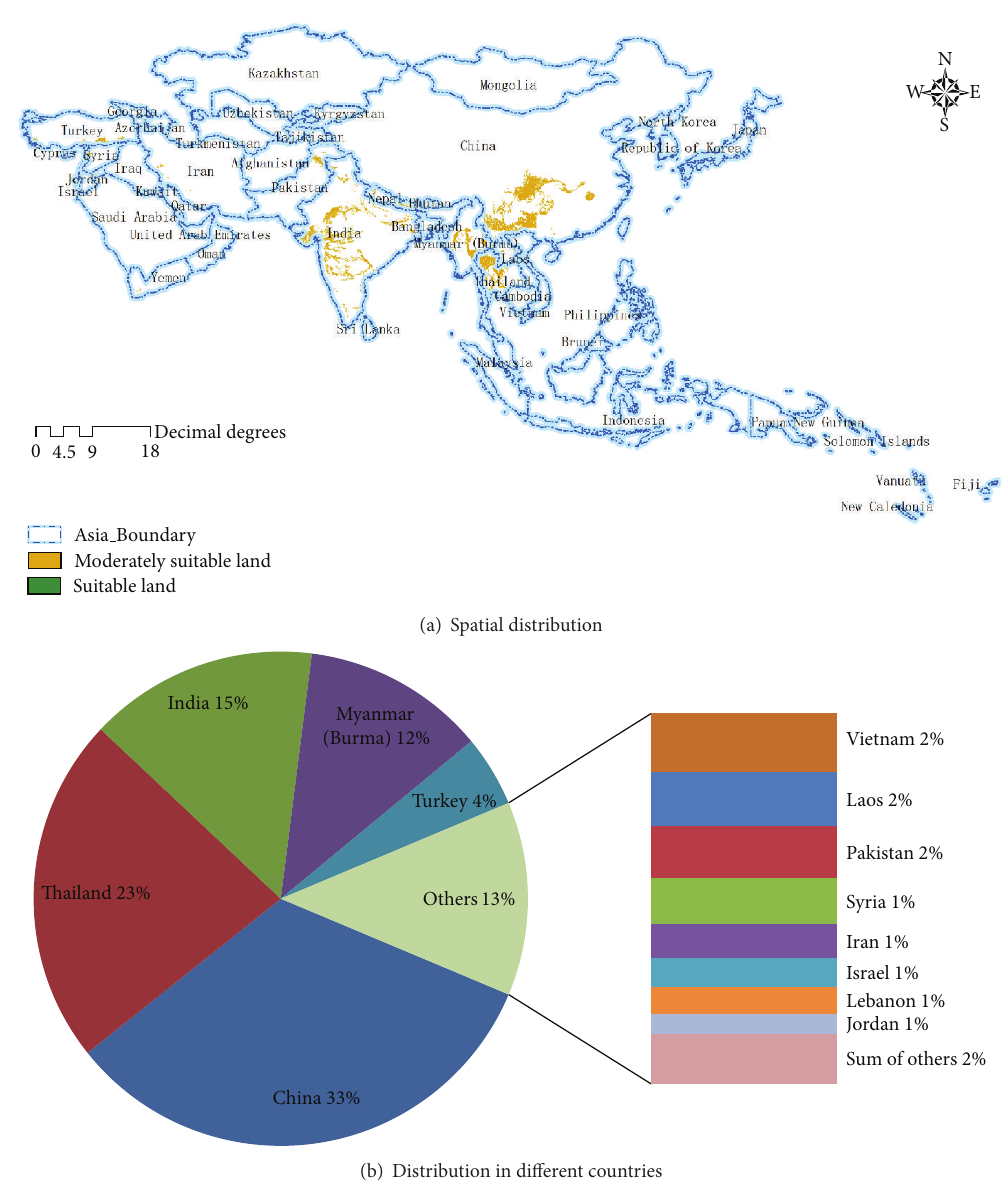
Figure 4: Distribution of marginal land resources for